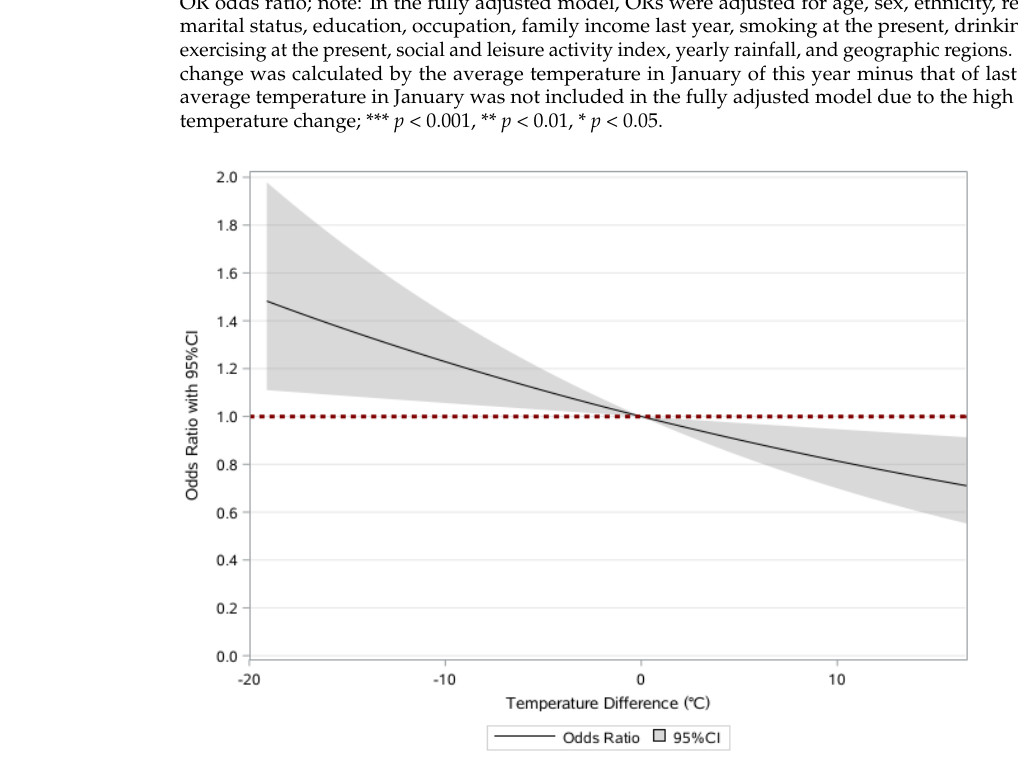
Figure 3. Restricted cubic splines for the associations between temperature change and frailty.